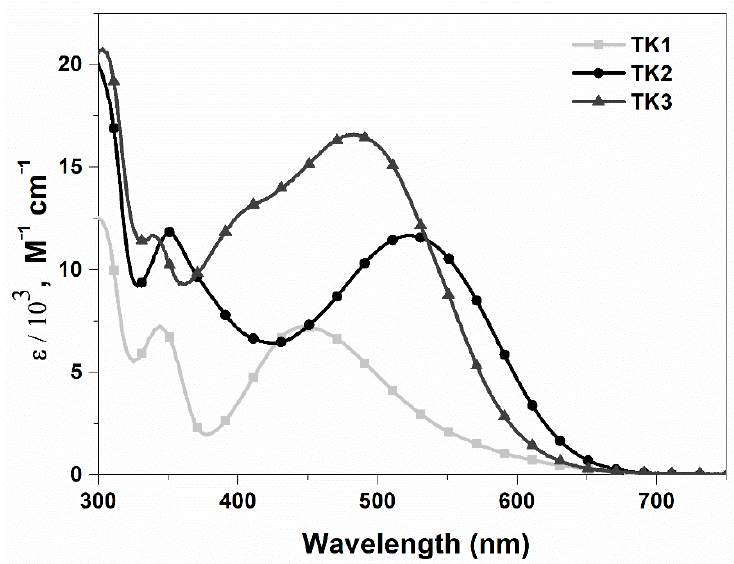
Figure 9. Absorption spectra of TK1 , TK2 and TK3 in CH ₂ Cl ₂ solution. Reprinted (adapted) with permission from ref. [75]. Copyright {2014} “The Royal Society of Chemistry.”.